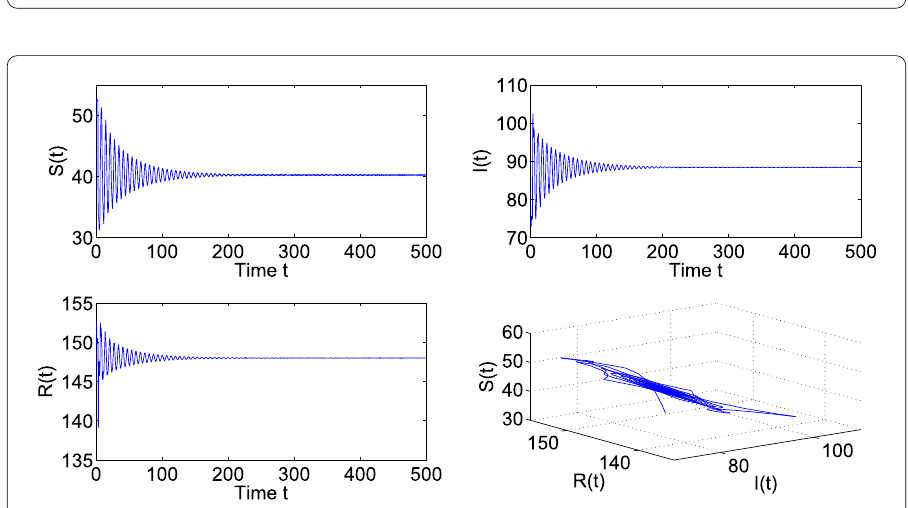
Figure 8 E ∗ is locally asymptotically stable when τ 1 = 2.895 < τ ∗ 10 = 4.0945 and τ 2 = 0.55 ∈ (0, τ 20